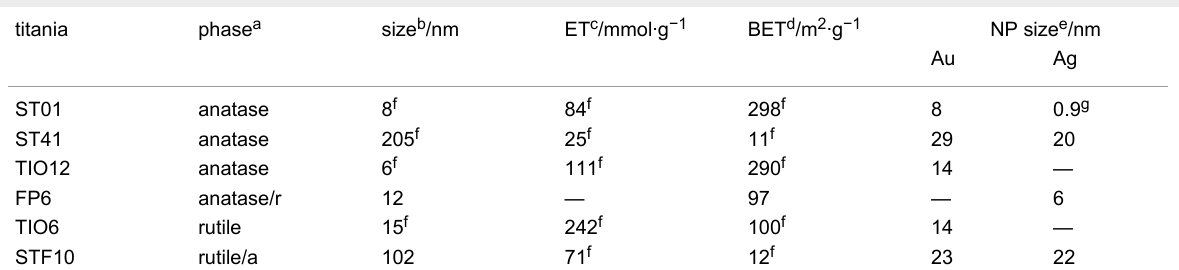
Table 1: Properties of titania photocatalysts used for metal deposition and crystallite sizes of gold and silver NPs.